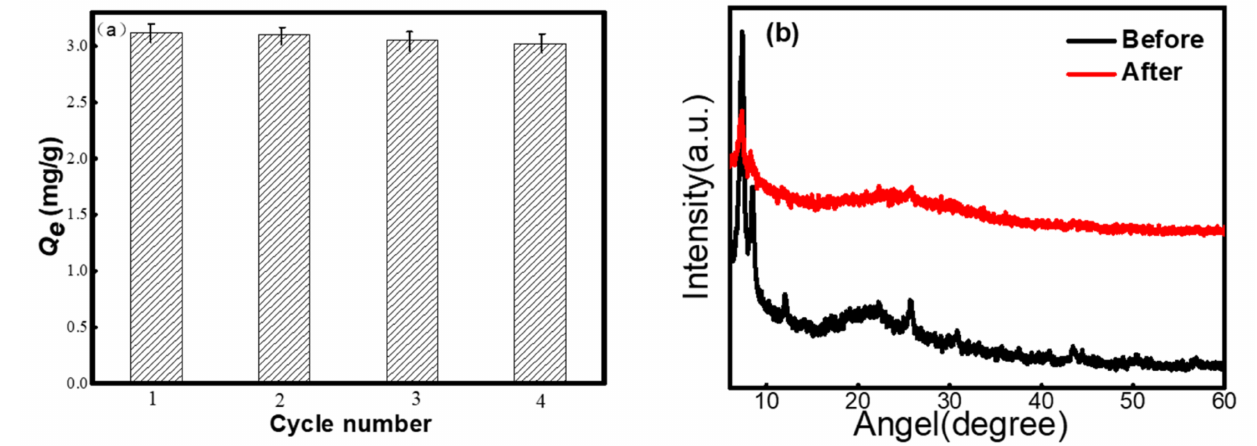
Figure 6. ( a ) Desorption and reuse efficiency of UiO-66 ( C 0 = 20 mg · L − 1 , V = 20 mL, m (UiO-66) = 10 mg, pH = 3 and 298.15 K); ( b ) XRD of UiO-66 before and after In(III)